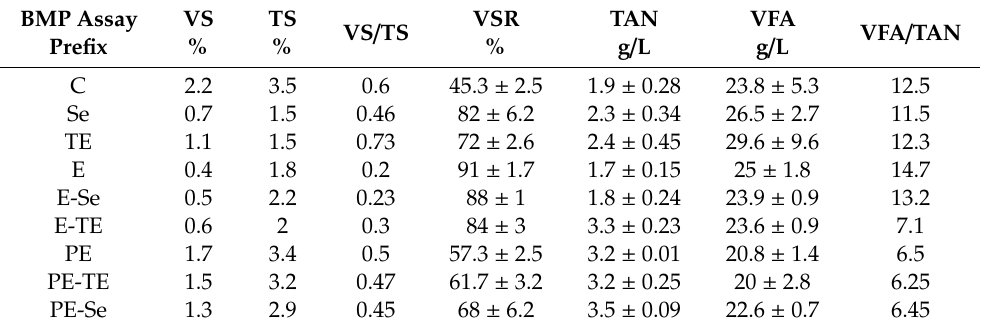
Table 5. Physiological characteristics of the BMP assay liquor on day 30 (assay